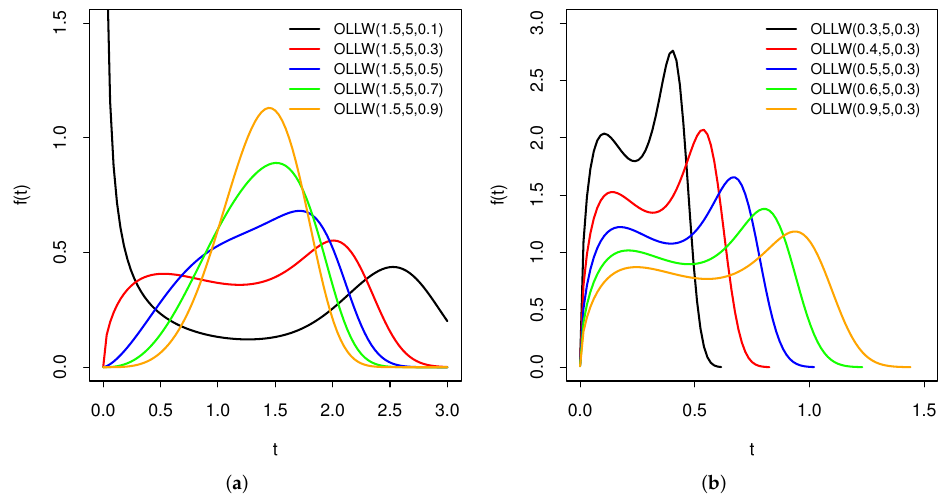
Figure 1. Plots of the OLLW density. ( a ) Changing τ , λ = 1.5 and α = 5. ( b ) Changing λ , α = 5 and τ =